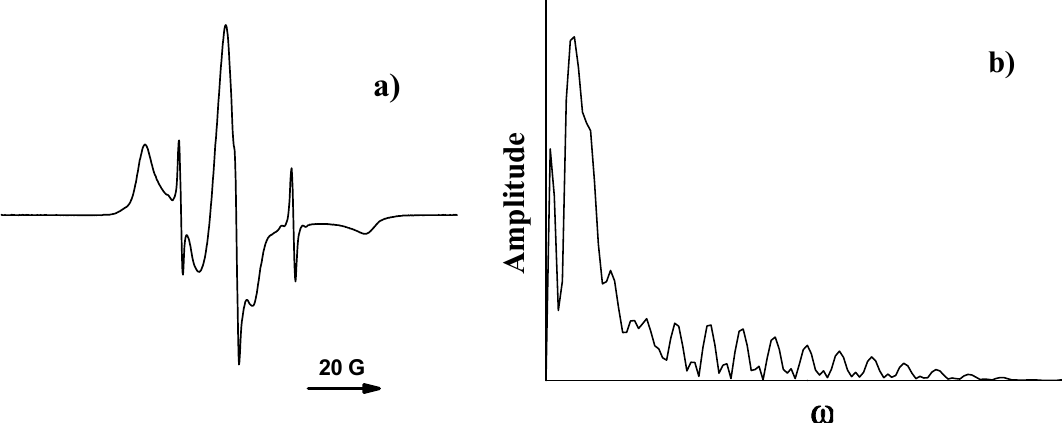
Figure 3. The EPR spectrum of 4-oxo-2,2,6,6-tetramethylpiperidine-1-oxide (TEMPONE) in swollen poly(D,L-lactide) film ( a ) and the absolute value of its Fourier image ( b ): the periodic pattern corresponds to the narrow triplet signal.